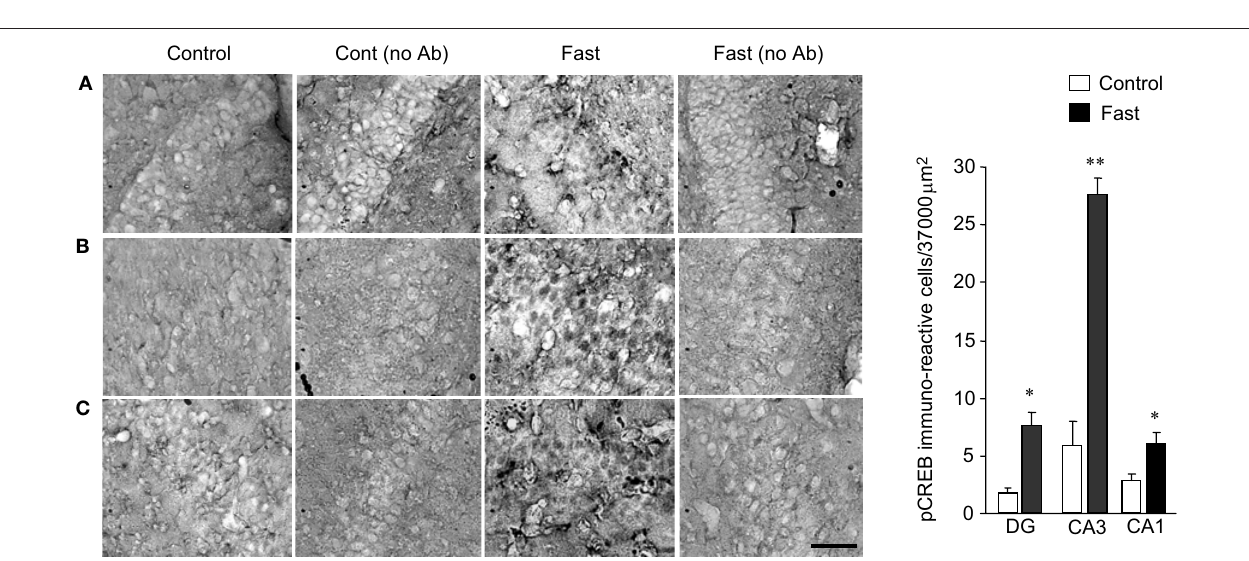
FIGURE 1 | pCREB immunoreactivity in the arcuate nucleus of the hypothalamus in control (A, B) and fasted (C, D) rats. (B) and (D) were processed without a primary antibody. (E) Results were quantifi ed for the mean ± SEM (standard error of the mean). Calibration: 50 μ m. ** p < 0.001.